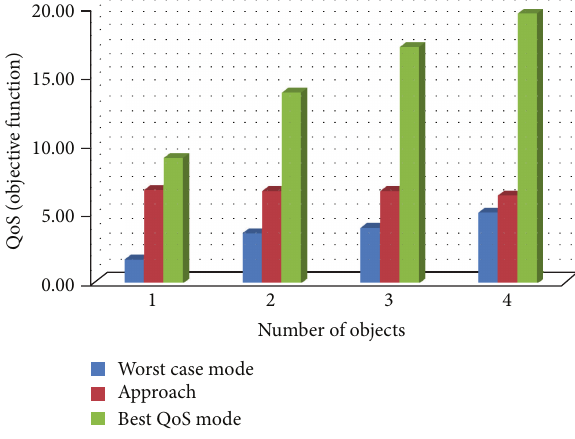
Figure 12: QoS variation of the